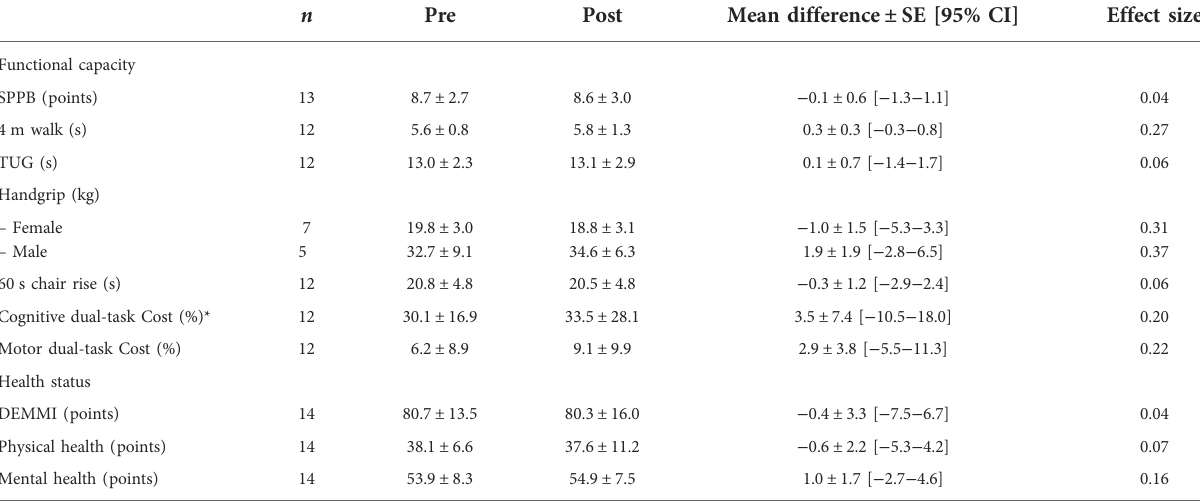
TABLE 4 Pre and post measurements (mean±SD) and